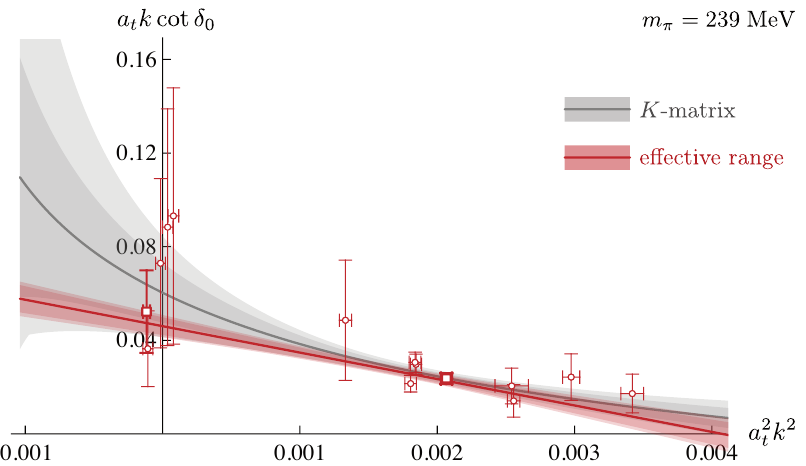
Figure 8. The S -wave effective range parameterisation from eq. (4.11) (red) and reference ampli- tude eq. (4.9) (grey) plotted as a t k cot δ as a function of the momentum-squared a 2 k 2 . The discrete t points show where the energies constrain the amplitudes by using eq. (2.5) to obtain t level-by-level. The bold square points are obtained from [000] A + , and the other points are from moving frame A 1 1 irreps with P -wave and higher partial waves fixed to zero. Both amplitudes are determined from the same spectra, as described in the